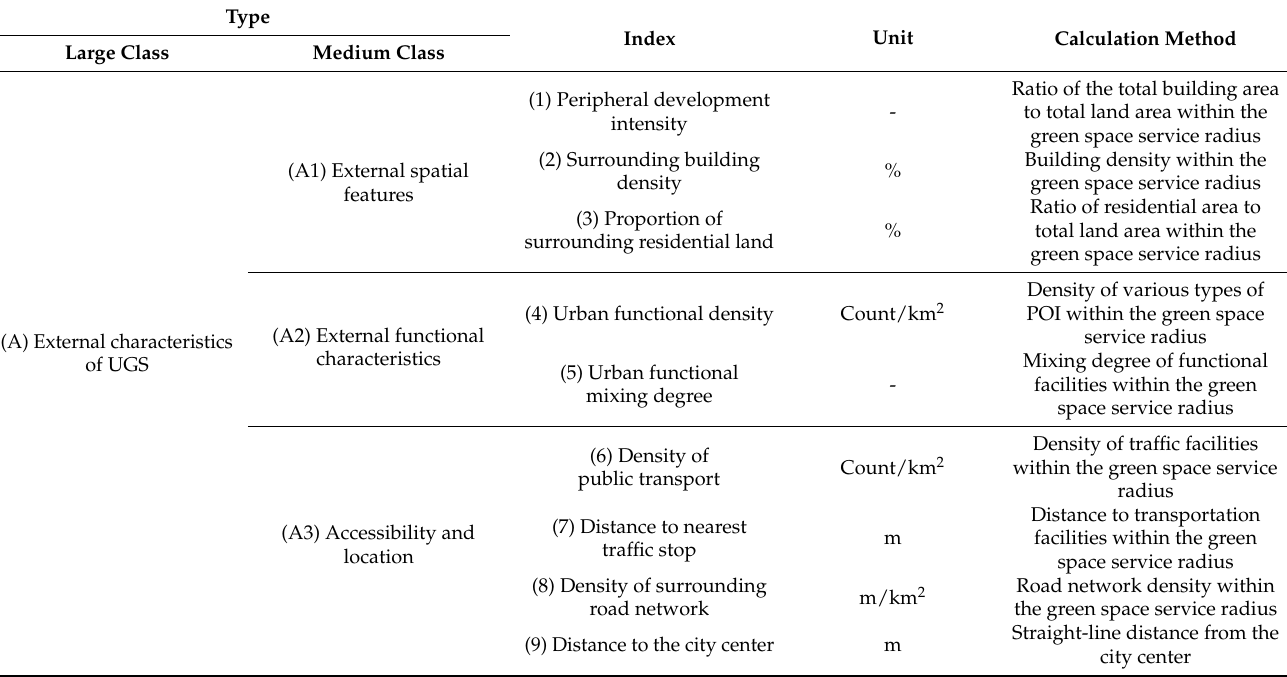
Table 2. The influence index of UGS